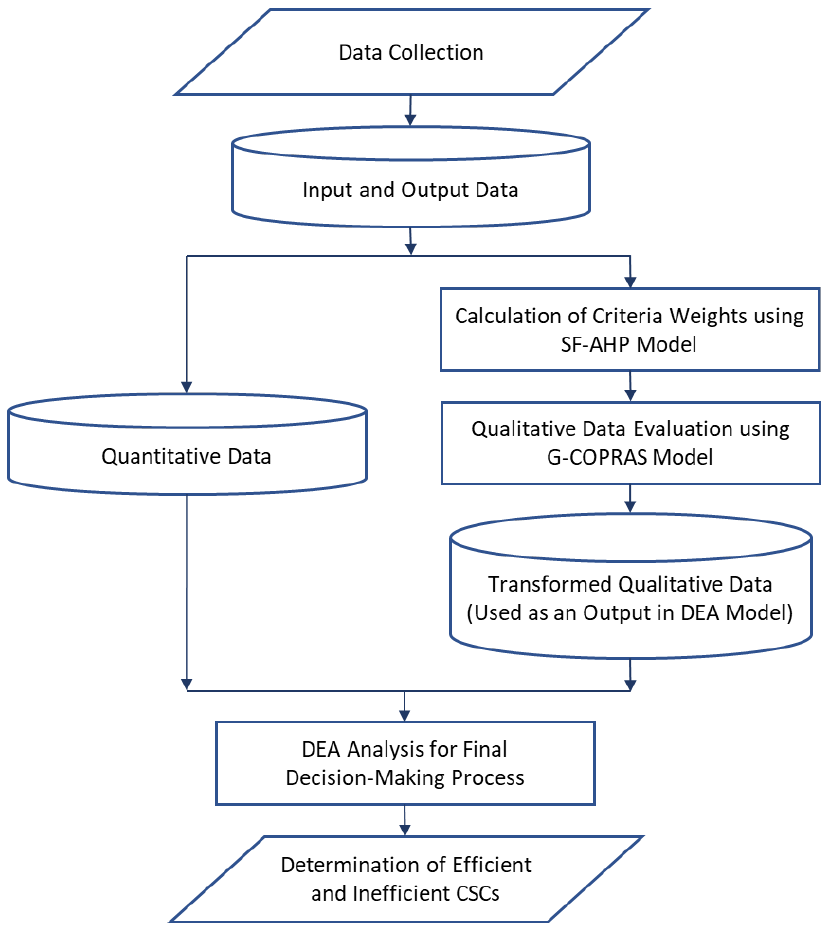
Figure 1. Flow chart of proposed methodology.